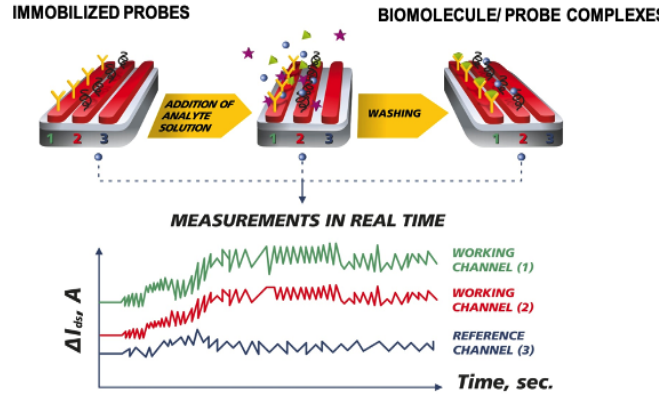
Figure 2. Schematic representation of the nanowire-based detection of protein molecules. Biospecific binding of the analyte molecules with the probe molecules, which are preliminarily immobilized on the nanowire surface (working channel) leads to a change in the nanowire’s conductance. In case of absence of the biospecific binding with the nanowire, whose surface was either not sensitized with the probe molecules, or was sensitized with the probes, which do not interact biospecifically with the analyte molecules, no change in the conductance occurs (control channel).